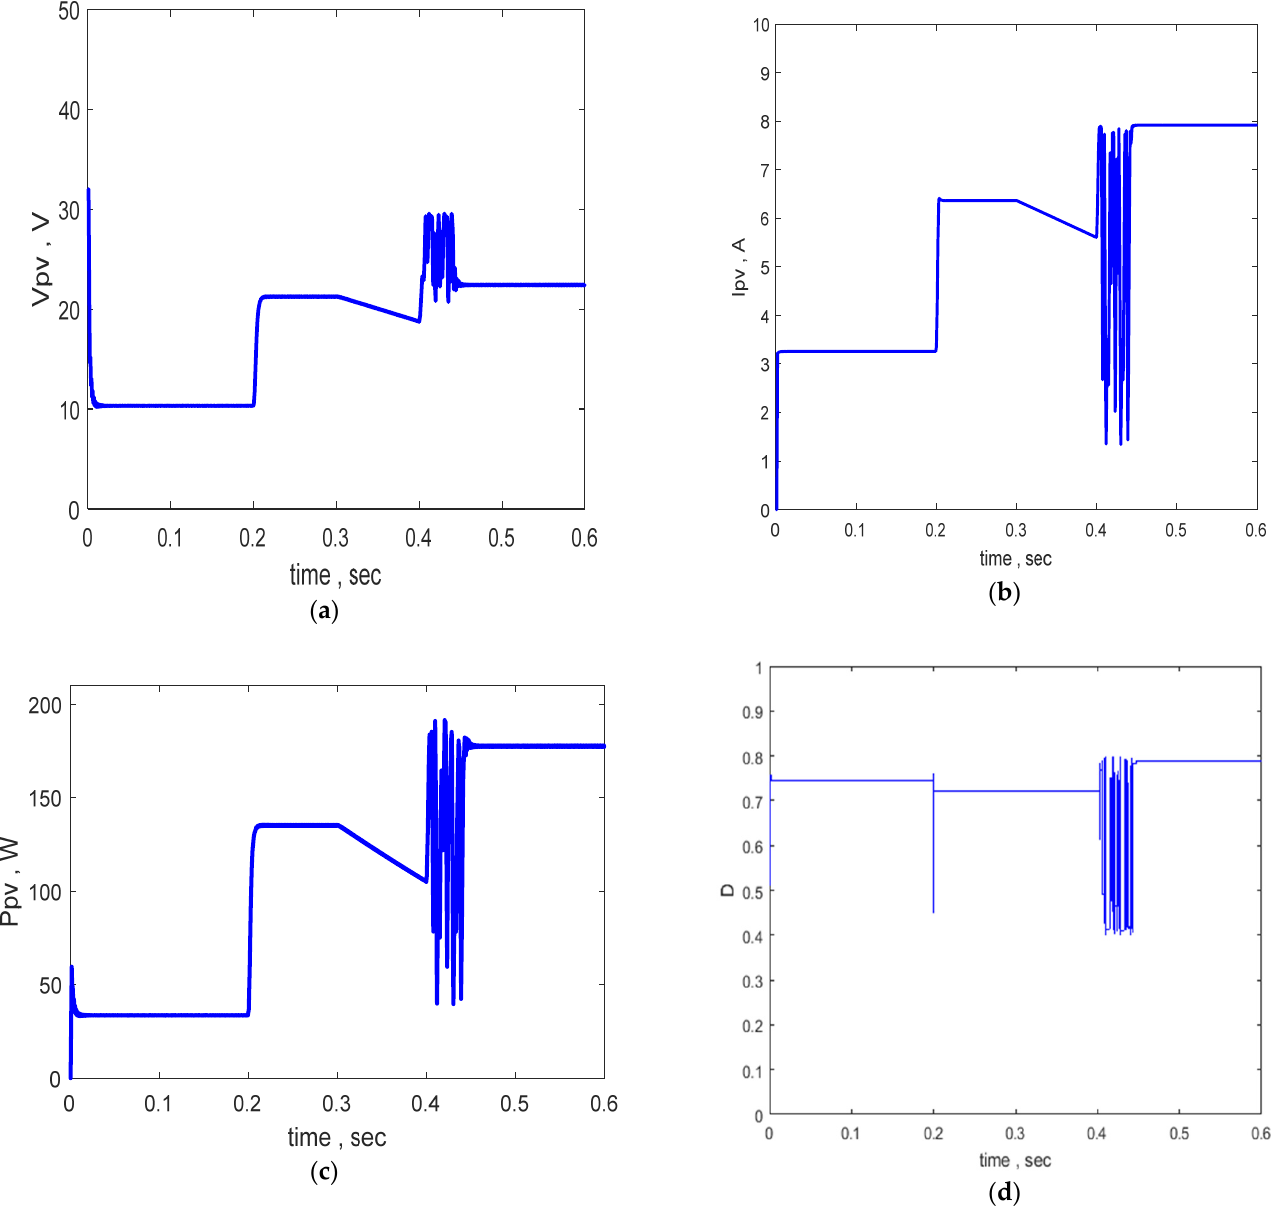
Figure 13. PV array output: ( a ) Vpv, ( b ) Ipv, ( c ) Ppv, ( d ) duty cycle (under the applied fault and confirming the proposed method during the uncertainty).